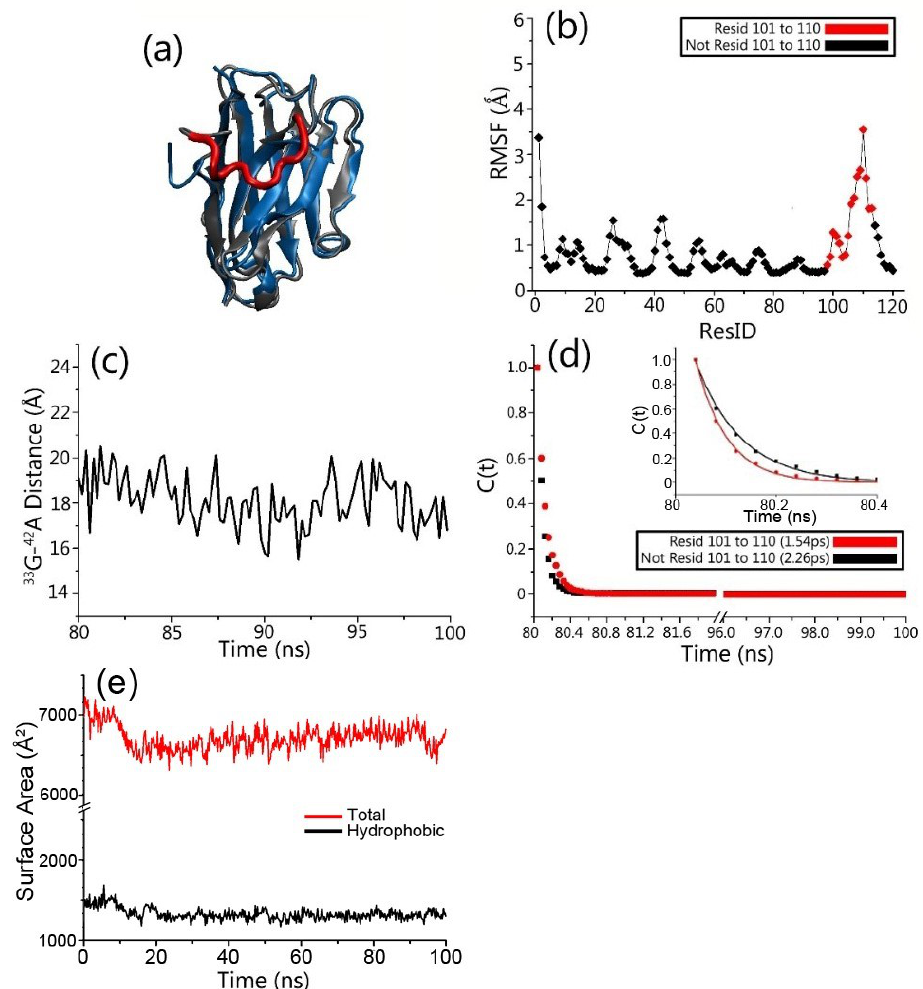
Figure 3. The CDR3 loop is highly flexible while gammabody framework is stable during simulations of gammabody in apo form. ( a ) Superimposed modeled structures of the native (blue ribbon) and engineered gammabody (gray and red ribbon); ( b ) residue-based RMSF profile; ( c ) 33 G– 42 A distance for grafted A β sequences in gammabody; ( d ) the solvent water molecule residence time profiles for engineered gammabody with A β residues; and ( e ) Total solvent accessible surface area (SASA) of gammbody for non CDR3 regions, red line: total SASA, black line: hydrophobic SASA. RMSF: root-mean-square